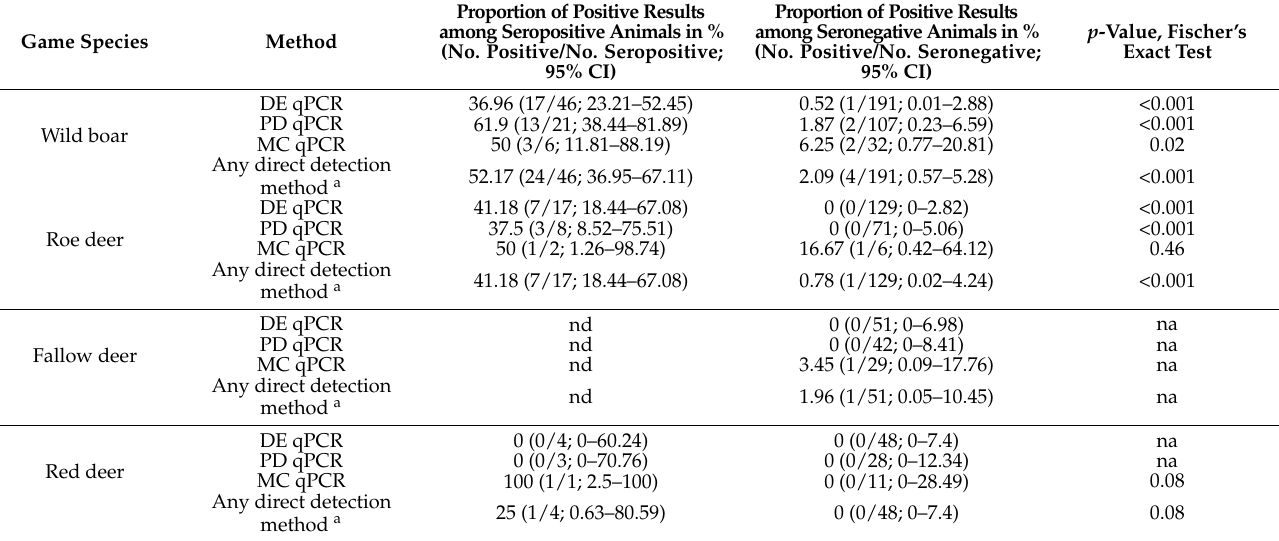
Table 2. Proportion of positive results in direct detection of Toxoplasma gondii in seropositive and seronegative wild boar and